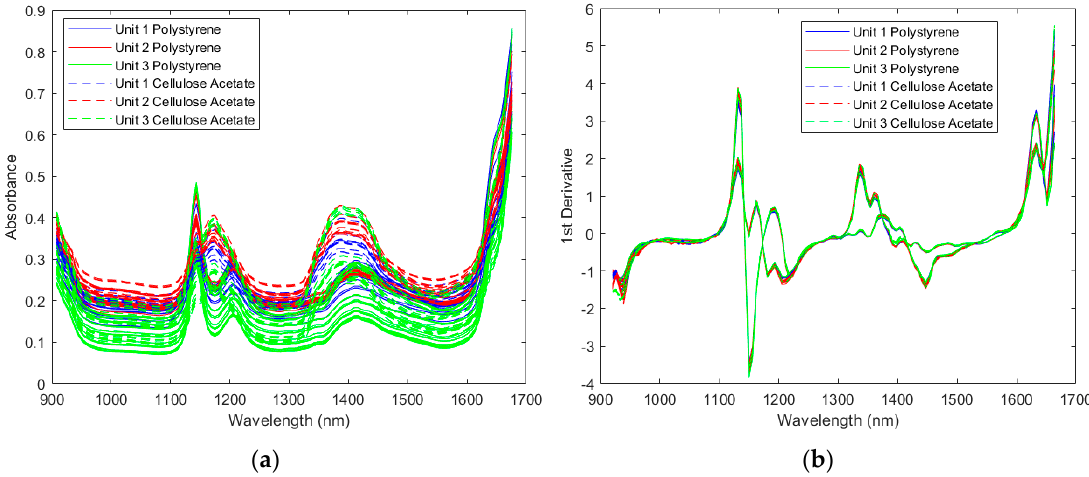
Figure 1. Spectra of example polymer samples by three instruments: ( a ) raw spectra; ( b ) preprocessed spectra by Savitzky-Golay 1st derivative (5 smoothing points and 3rd polynomial order) and standard normal variate (SNV).